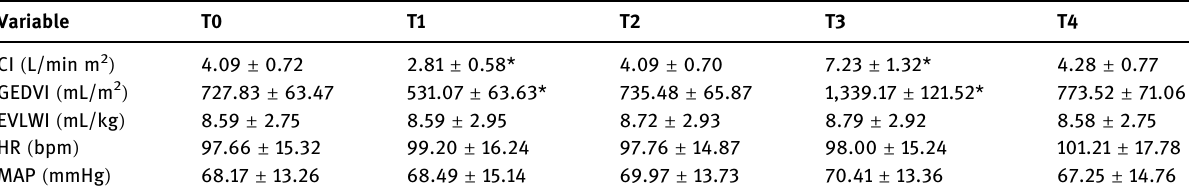
Table 2: PICCO parameters ( mean value ± standard deviation ) changed by CRRT at di ff erent time points for 29 datasets obtained from 15 patients Variable